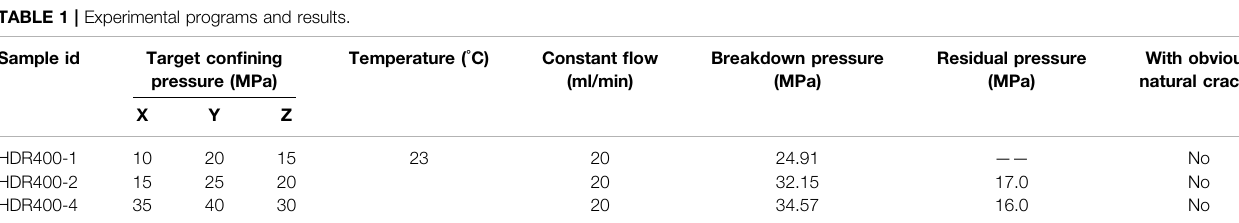
TABLE 1 | Experimental programs and